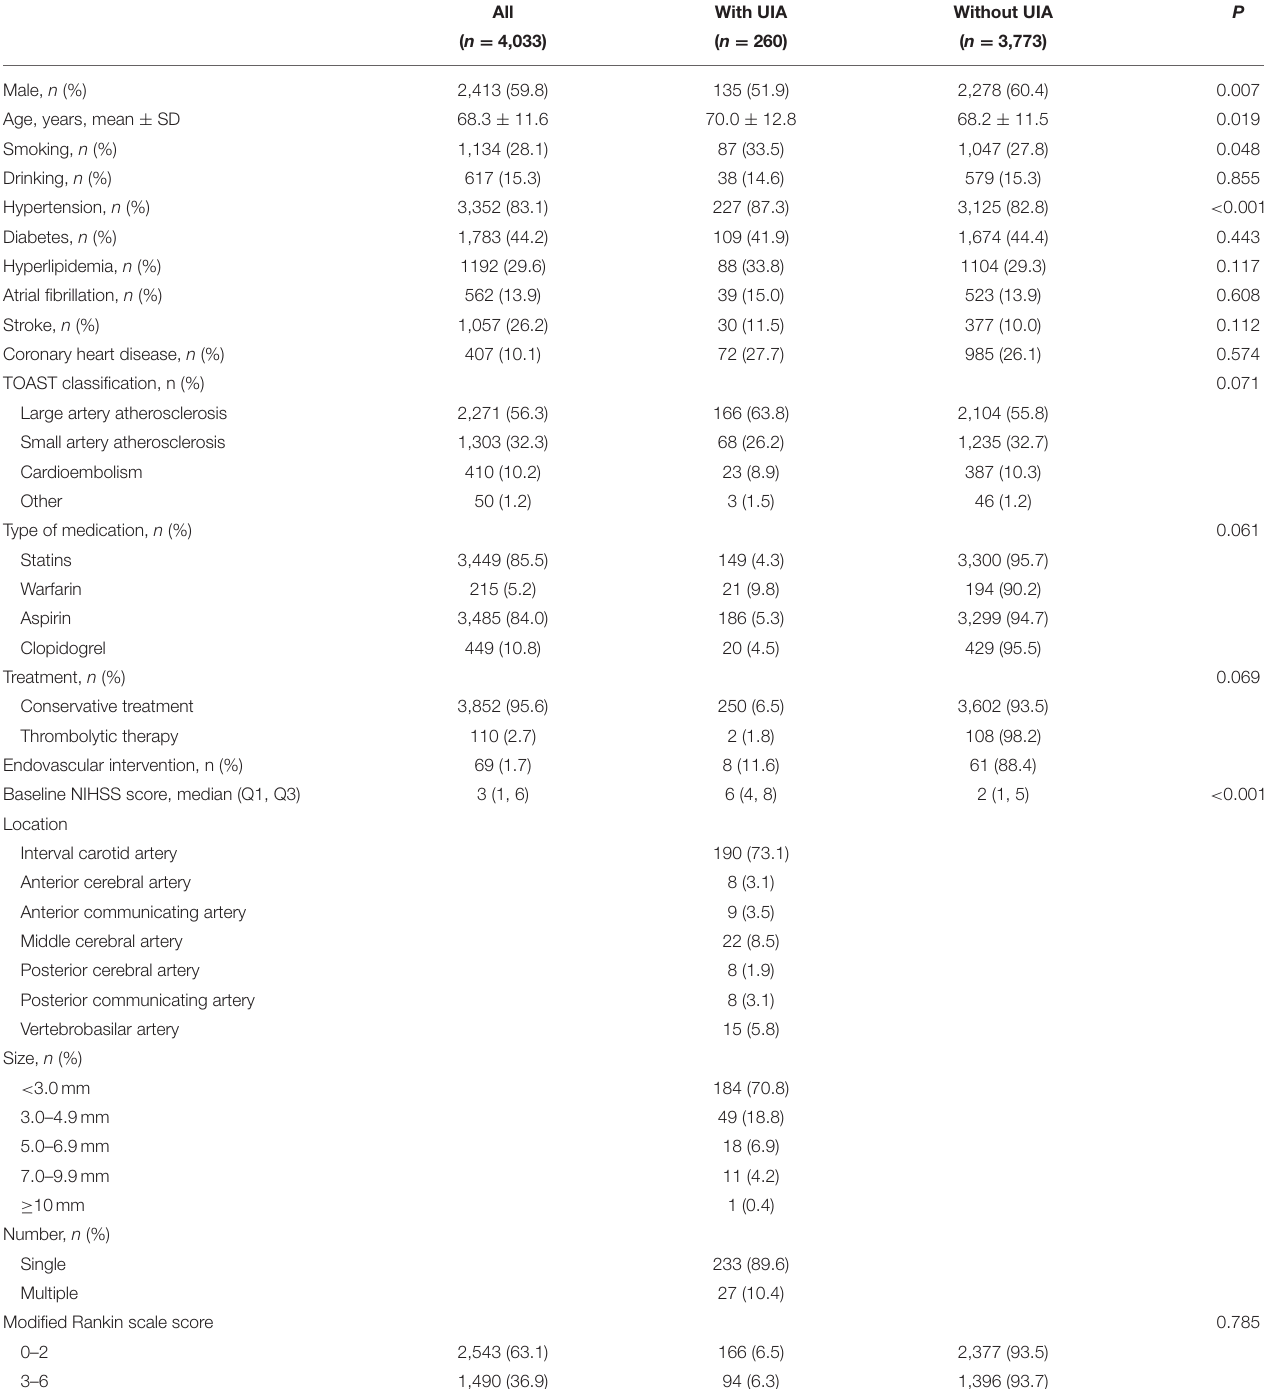
All With UIA Without